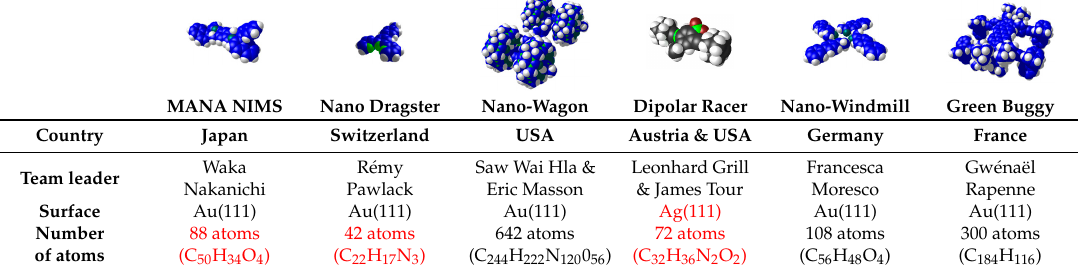
Table 1. The six registered participants and their respective nanocars, with their characteristic parameters: country, team leader, landing surface, and number of atoms of their nanovehicle (with the corresponding chemical formula). In red, the parameters outside of the original rules [28] but accepted by the jury.